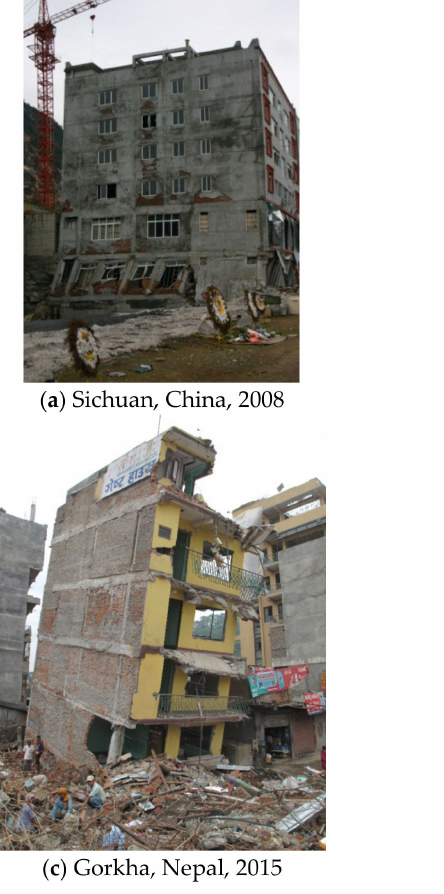
Figure 12. Damage type 7—example of buildings collapsed due to the soft-storey